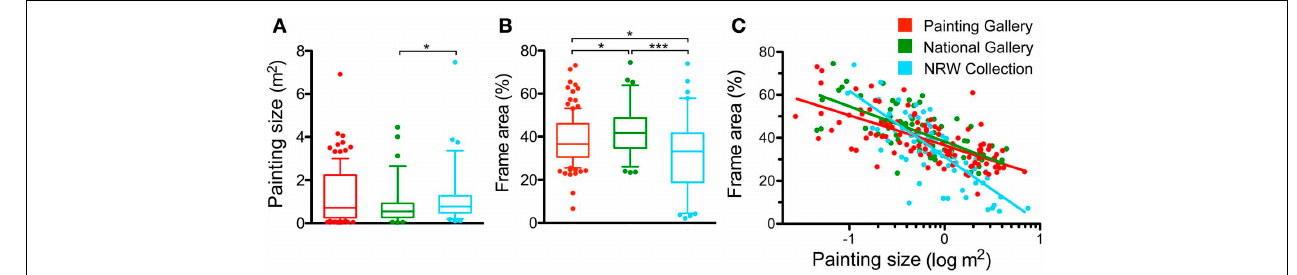
FIGURE 4 | Means of painting size and relative frame size. The physical size of the paintings (without frame) is given in m 2 (A) and the relative frame size as the percentage of the area that each frame covers in the PwF image (B) . The whiskers represent the 5–95 percentiles. Differences are significant at p < 0 . 05 ( ∗ ) and p < 0 . 001 ( ∗∗∗ ), as indicated. (C) Scatter graph of relative